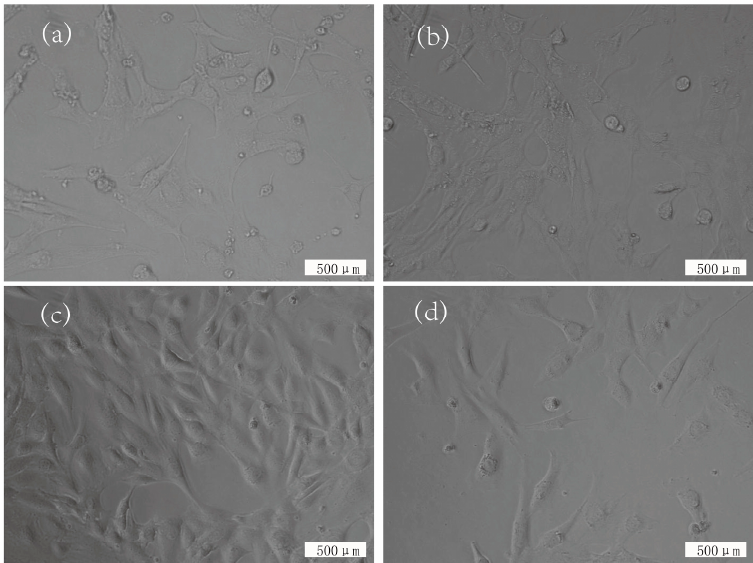
Figure 8. Inverted microscope images (20 × ) for the MC3T3-E1 cells cultured with extracts originating from: AZ31 ( a ); AHEC/AZ31 ( b ); and HA/AHEC/AZ31 ( c ) specimens; and the negative control group ( d ) for 7d.